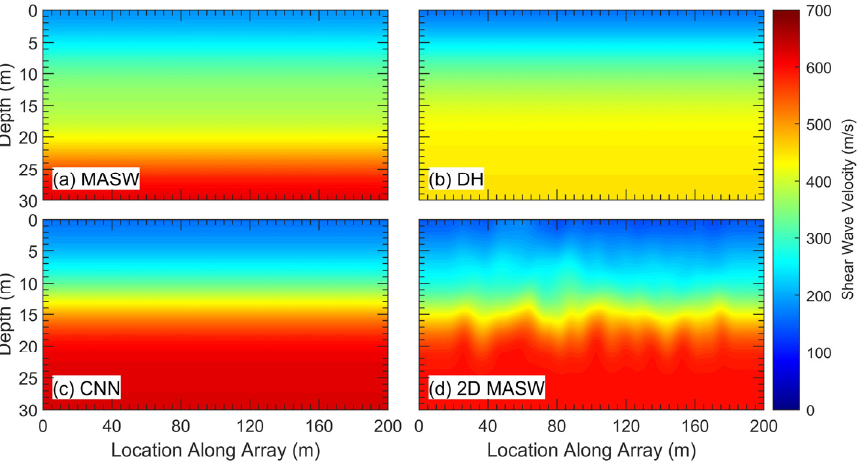
Figure 4. The four smoothed 2D V S starting models for FWI based on: ( a ) 1D MASW, ( b ) downhole testing, ( c ) CNN machine learning, and ( d ) pseudo ‐ 2D MASW.